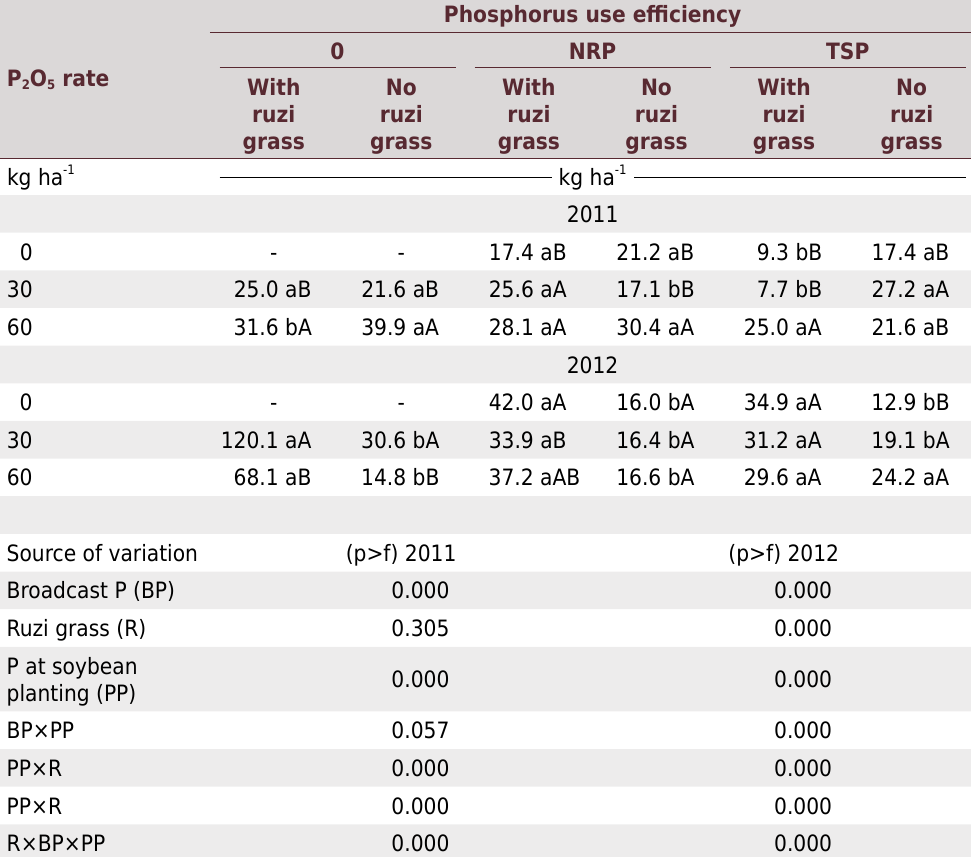
Table 6. Phosphorus use efficiency by soybeans grains and P values (p>f) as affected by phosphate fertilizers (soluble and reactive) broadcast in the presence and absence of ruzi grass and P rates applied to soybean seed furrows (0, 30, and 60 kg ha -1 of P 2 O 5 in the form of